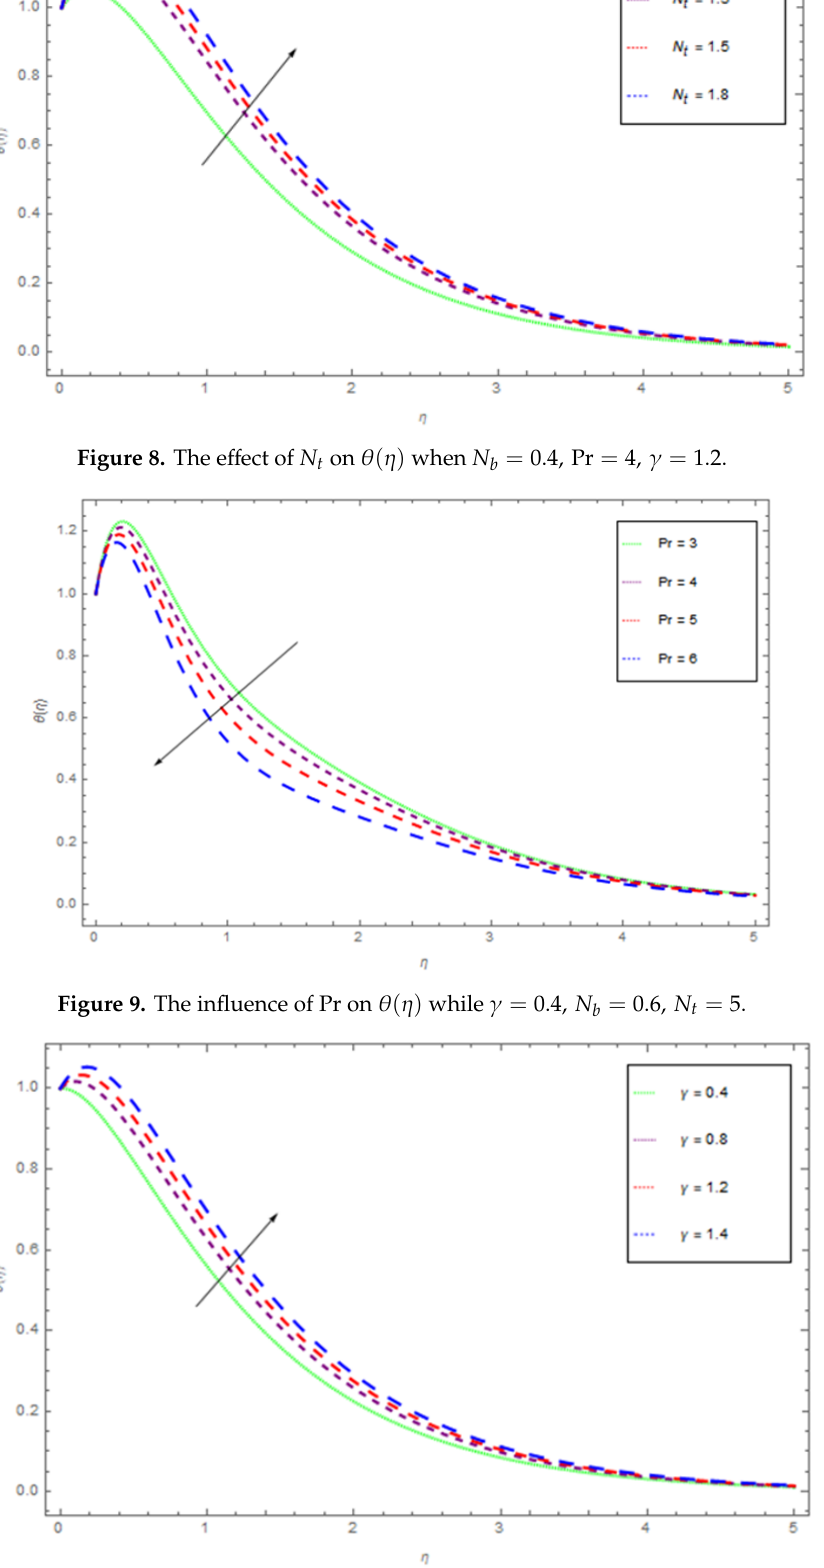
Figure 10. The influence of on ( ) when 0.7, 0.5,Pr 4 b t N N .